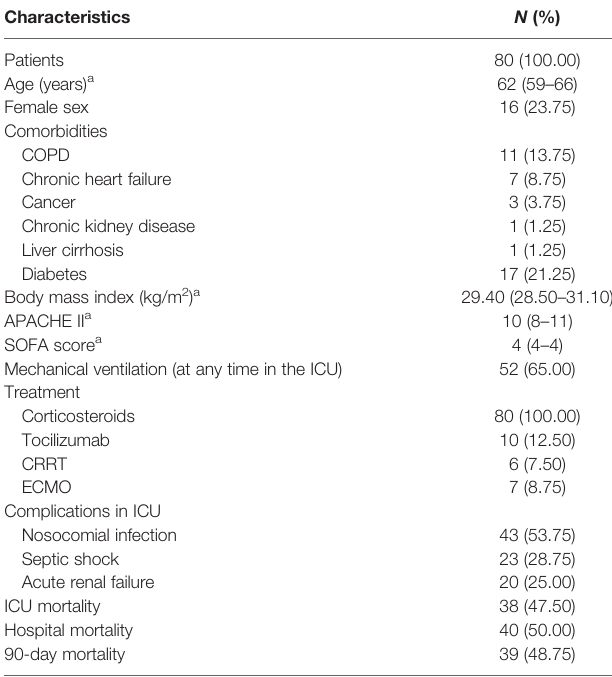
TABLE 1 | Clinical characteristics of COVID-19